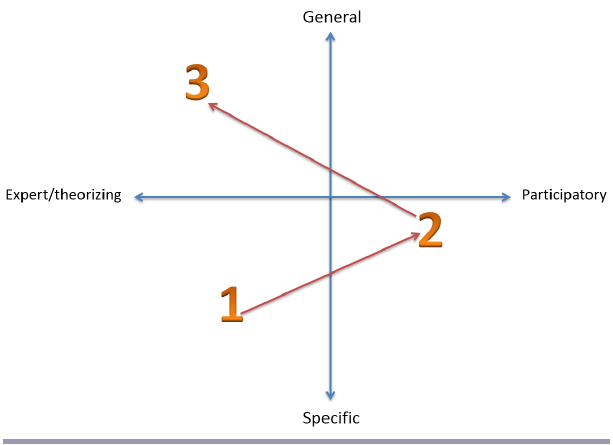
Fig. 6 . NeWater Scientists and the Shadow Network of activist- scientists’ research journey